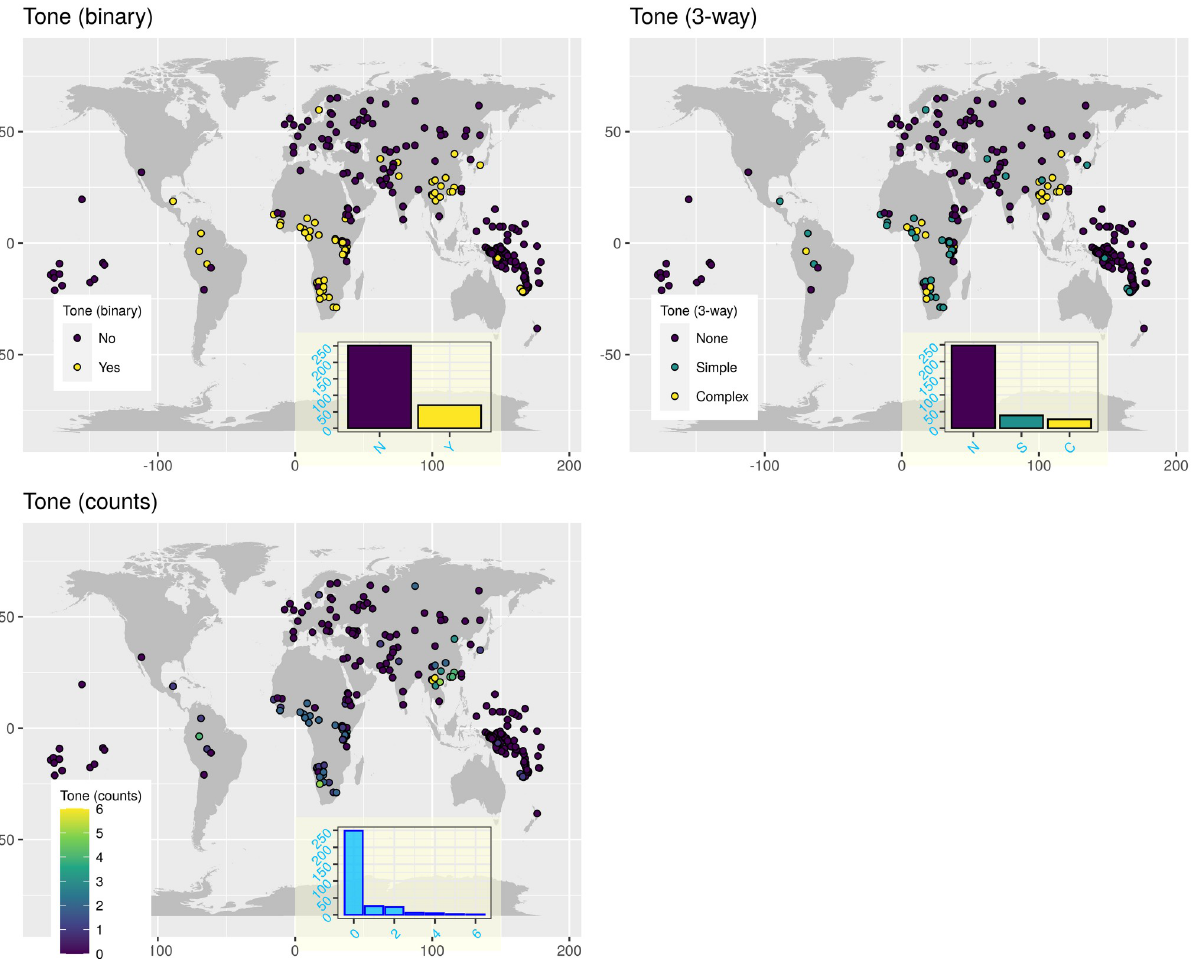
Fig 3. The distribution of the agreement tone. Each circle on the maps represents a unique language, and its colour represents is value. The insets show the overall distributions across all the languages. Top-left: binary tone (inset horizontal axis: “N” = “No”, “Y” = “Yes”); top-right: 3-way classification (inset horizontal axis: “N” = “None”, “S” = “Simple”, “C” = “Complex”); bottom-left: tone counts. The maps were generated with the R package maps which uses public domain data from the Natural Earth project https://www.naturalearthdata.com/.